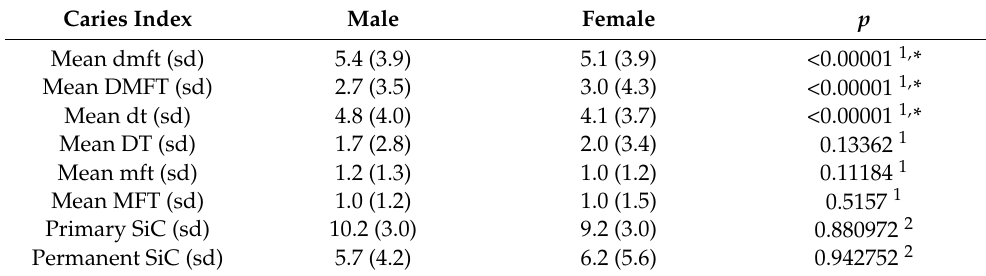
Table 4. Comparison of overall mean dmft/DMFT and SiC